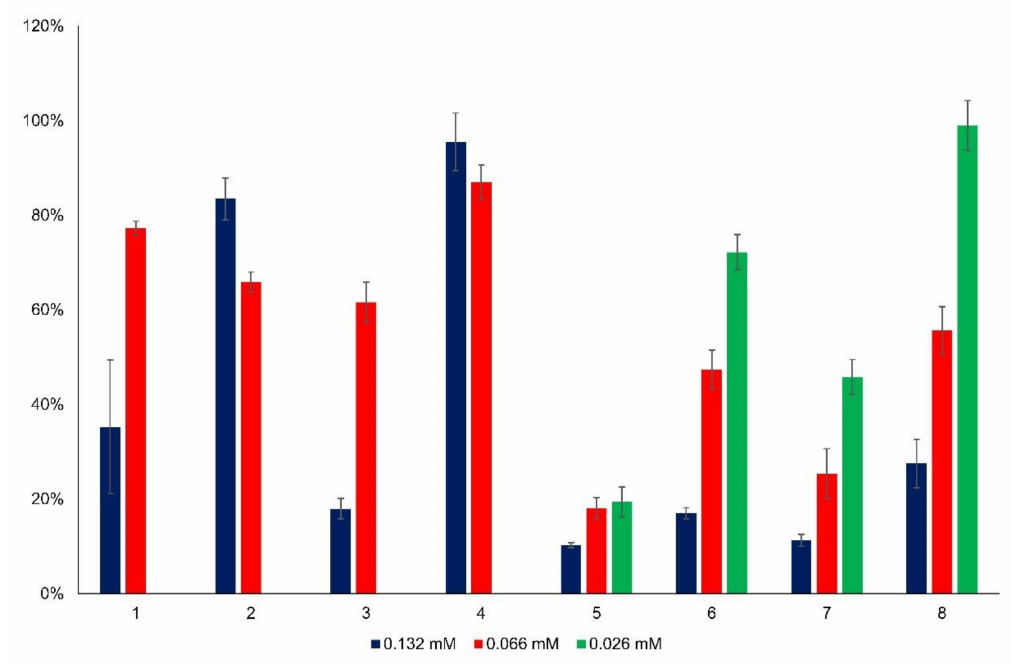
Figure 4. Viability (%) of HepG2 cells as a function of flavylium